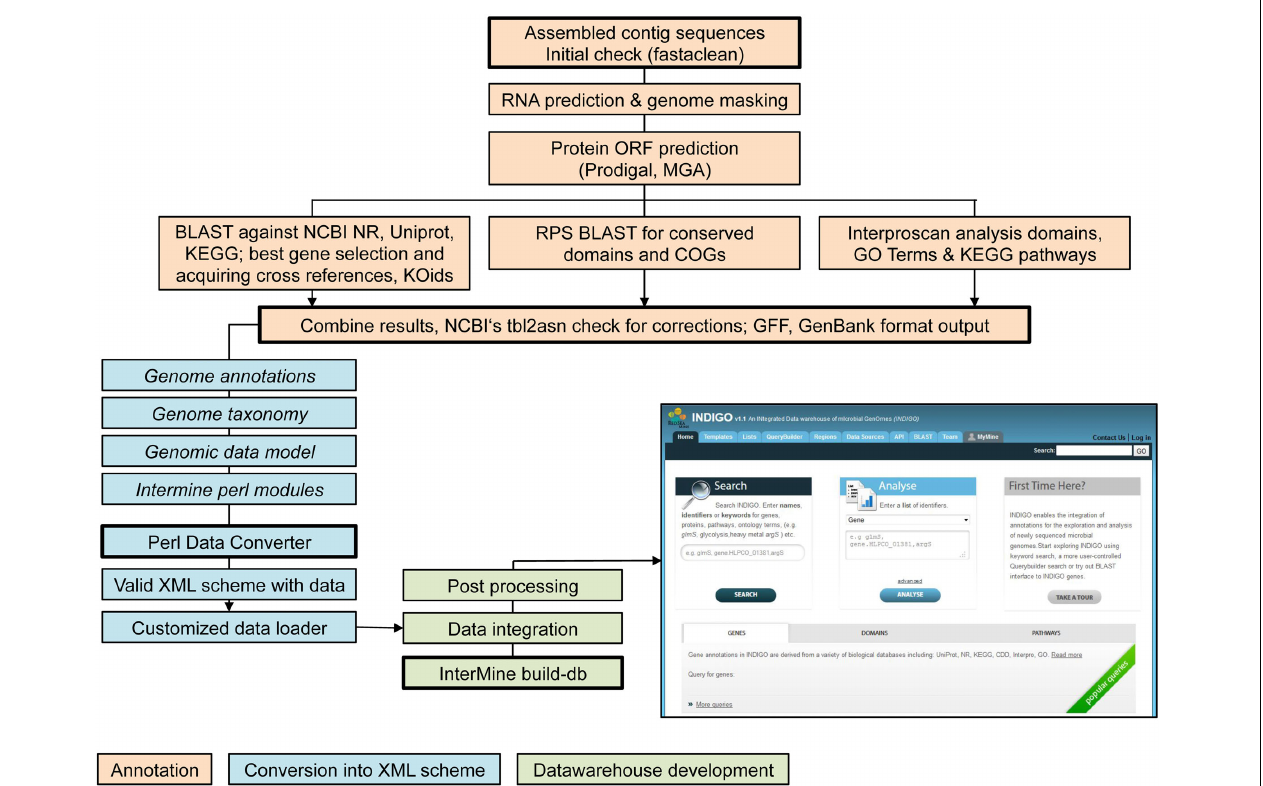
FIGURE 1 | Workflow of data integration into the INDIGO warehouse starting from assembled contig